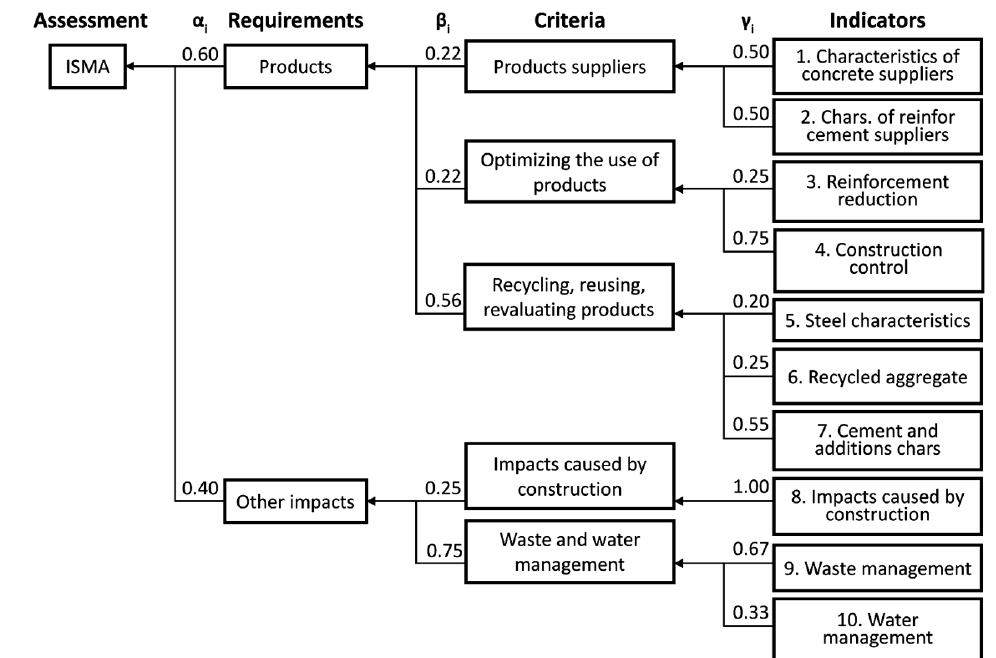
Fig. 1. Model requirement